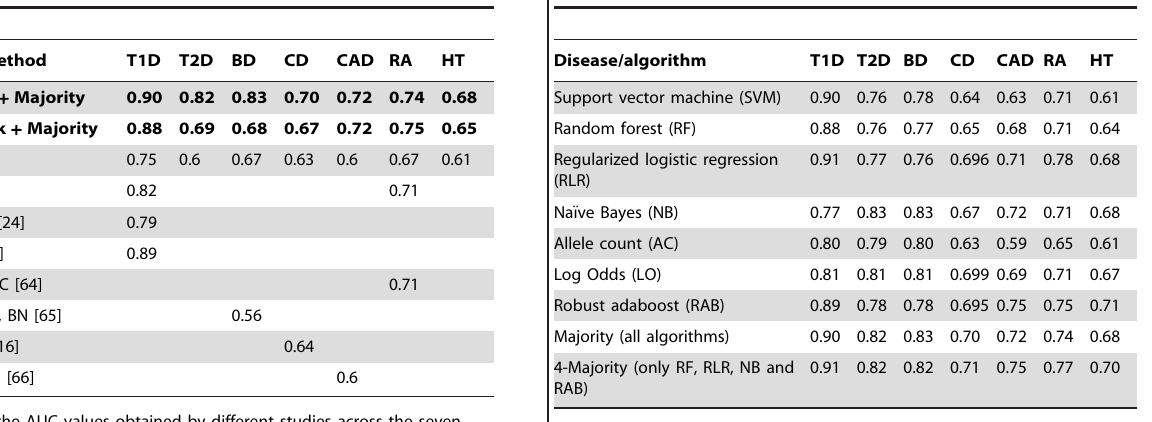
Table 1. Prediction performance for WTCCC data on test data.